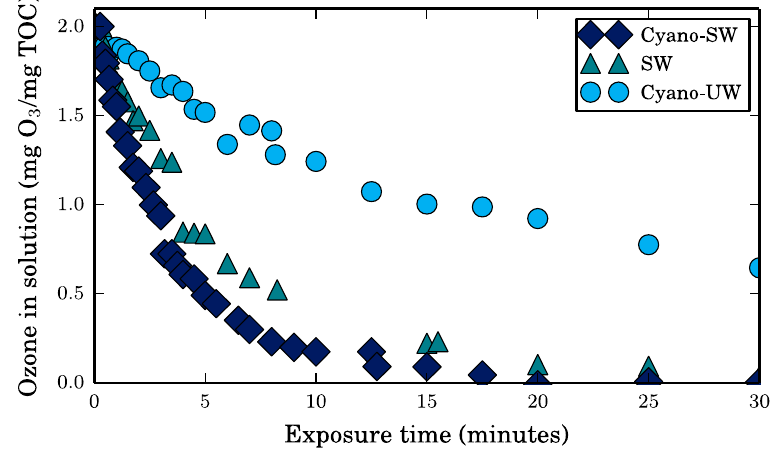
Figure 2. Ozone mass in solution (normalized) in 1 L batch solutions of surface water (SW), cyanobacteria-spiked ultrapure water (Cyano-UW), and cyanobacteria-spiked surface water (Cyano-SW). Ozone spiked to obtain a concentration of 2 mg of ozone per mg of total organic carbon (TOC) in solution. Experiments conducted at 23 °C.